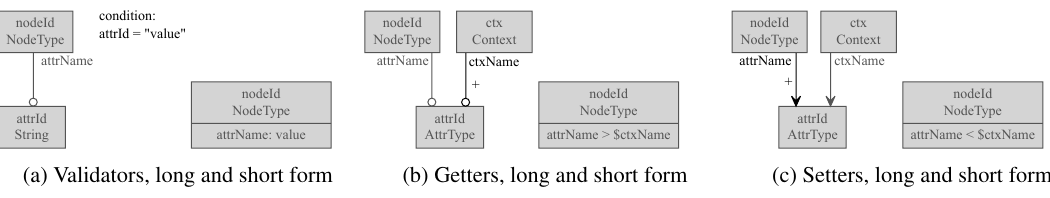
Figure 6. Shortcuts to define attribute-specific validators, setters and getters, long forms (left) and short forms (right)